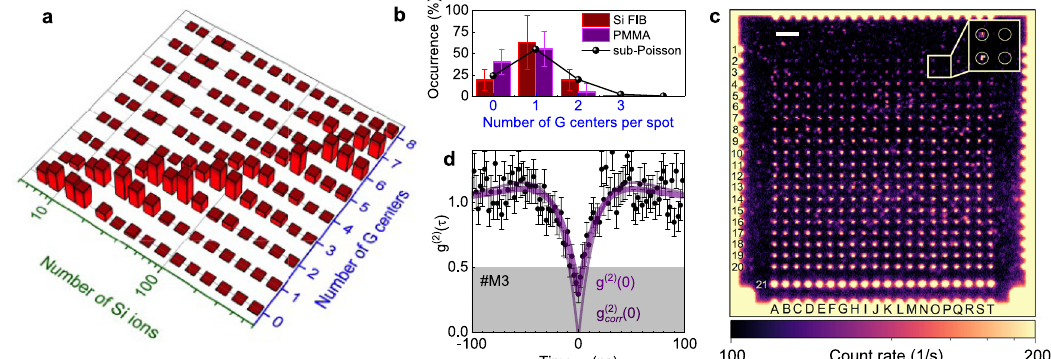
Fig.2|ScalablefabricationofsingleGcenterswithsub-100-nmprecisioninan SOIwafer. a Statisticshistogram representingthe probability distribution of the G centers depending on the number of implanted Si ions. b The occurrence prob- ability of G centers for FIB implantation (on average 25 Si ions per spot) and Si broad-beam implantation ( fl uence 1×10 12 cm − 2 ) through PMMA holes (nominal diameter 40nm). The solid line represents the sub-Poisson distribution with μ =4, asdescribed in the text. c ConfocalPLintensity mapoflocallycreatedG centersin